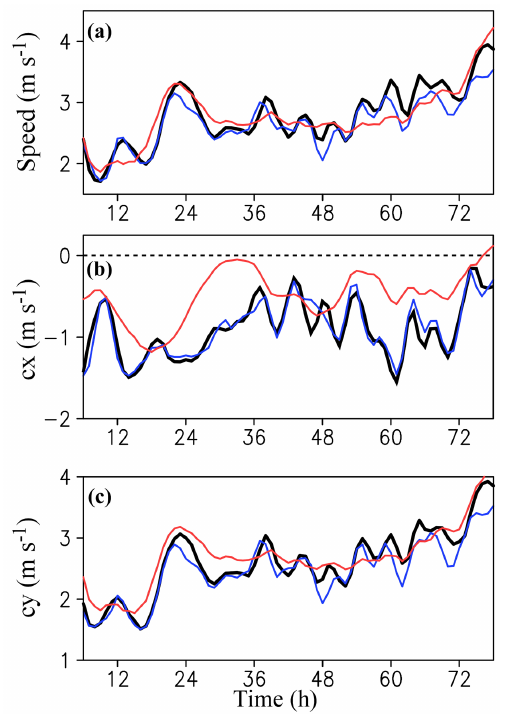
Figure 5. Time series of tropical cyclone speed (thick black), PVT speed (blue) and conventional steering (red): (a) magnitude, (b) zonal component and (c) meridional component.